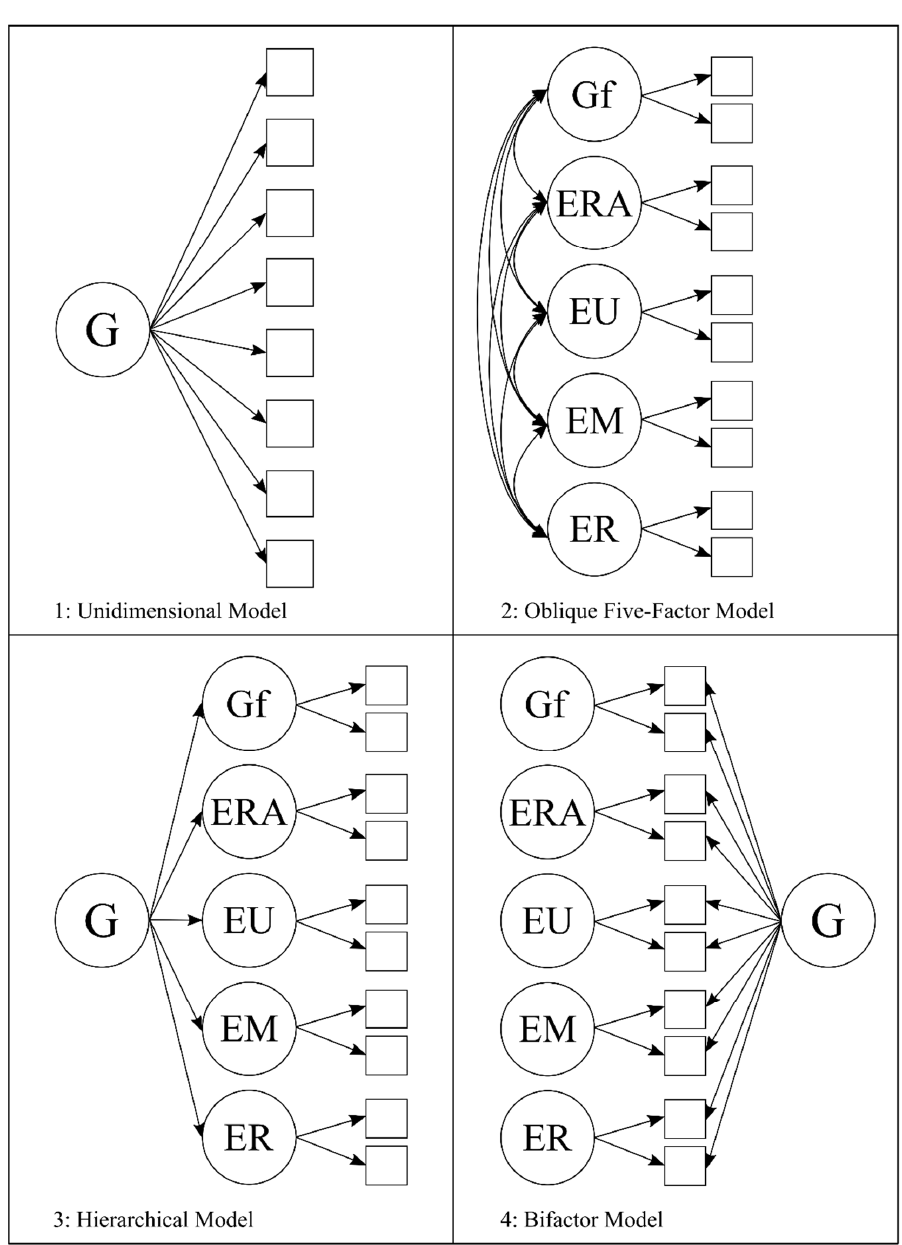
Figure 1. Simplified representation of tested models. G = General ability; Gf = fluid intelligence; ERA = emotion recognition ability; EU = emotion understanding; EM = emotion management; ER = emotion regulation.